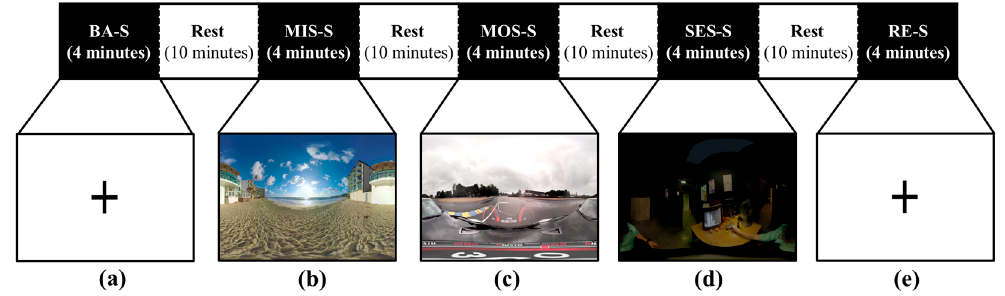
Figure 1. Total experiment flow: ( a ) Cross mark in the baseline session; ( b ) mild-stress session with beach scenery; ( c ) moderate-stress session with a car-racing situation; ( d ) severe-stress session with a dark, dingy room; ( e ) cross mark in the recovery session.